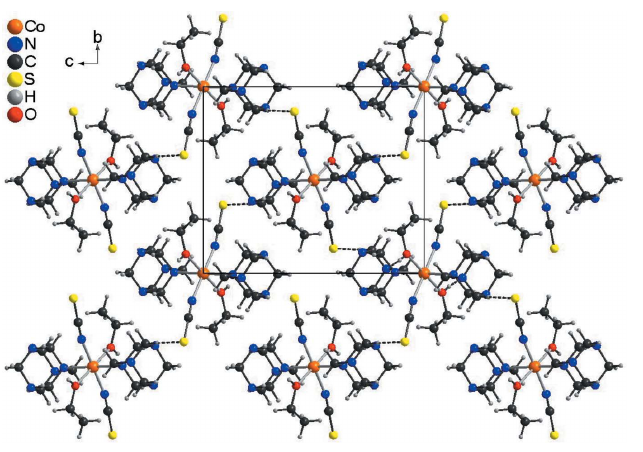
Figure 4 Crystal structure of compound 1 with a view along the crystallographic a - axis with intermolecular C—H (cid:2)(cid:2)(cid:2) S hydrogen bonding shown as dashed lines.